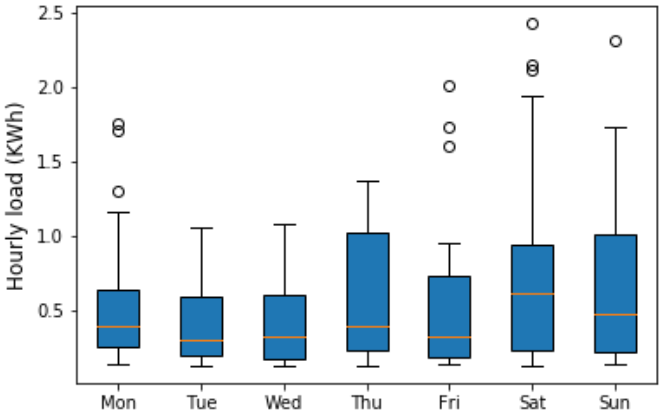
Figure 5. Boxplot statistics for House 33 over one week. (4 March to 11 March 2013).